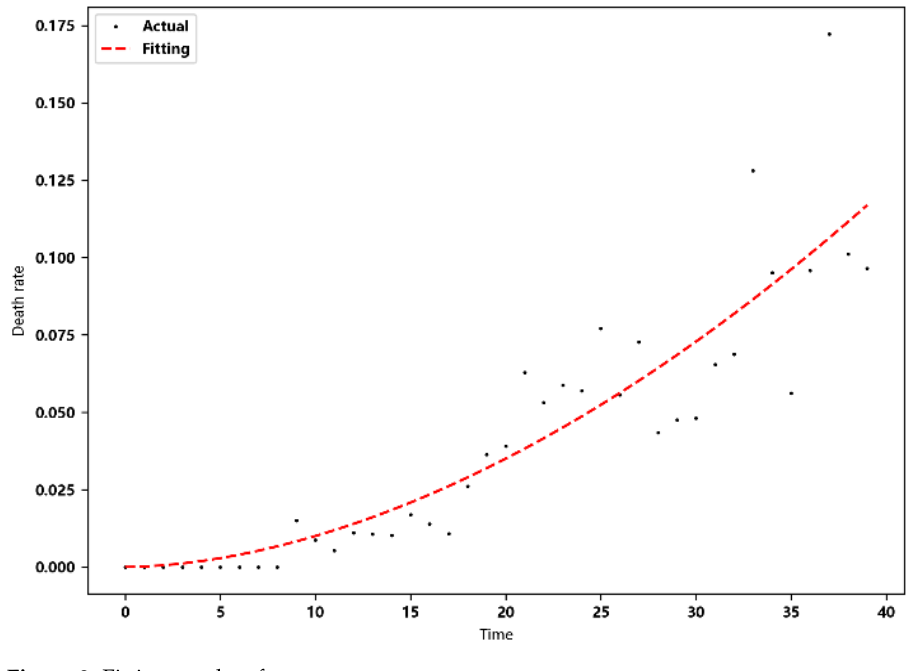
Figure 9. Fitting results of cure rate.